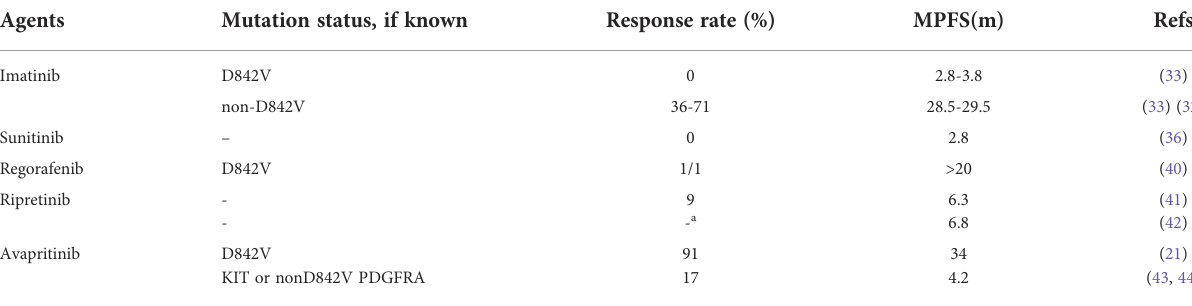
TABLE 1 Response rates and PFS of approved agents for PDGFRA-mutated